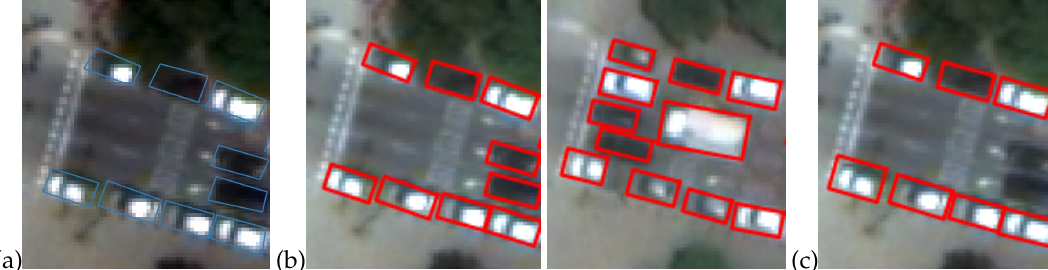
Figure 3. The data annotation postprocessing process for a small sample region; ( a ) raw polygons (only shown for one image); ( b ) converted OBB representations in both images; ( c ) overlapping OBBs denoting static